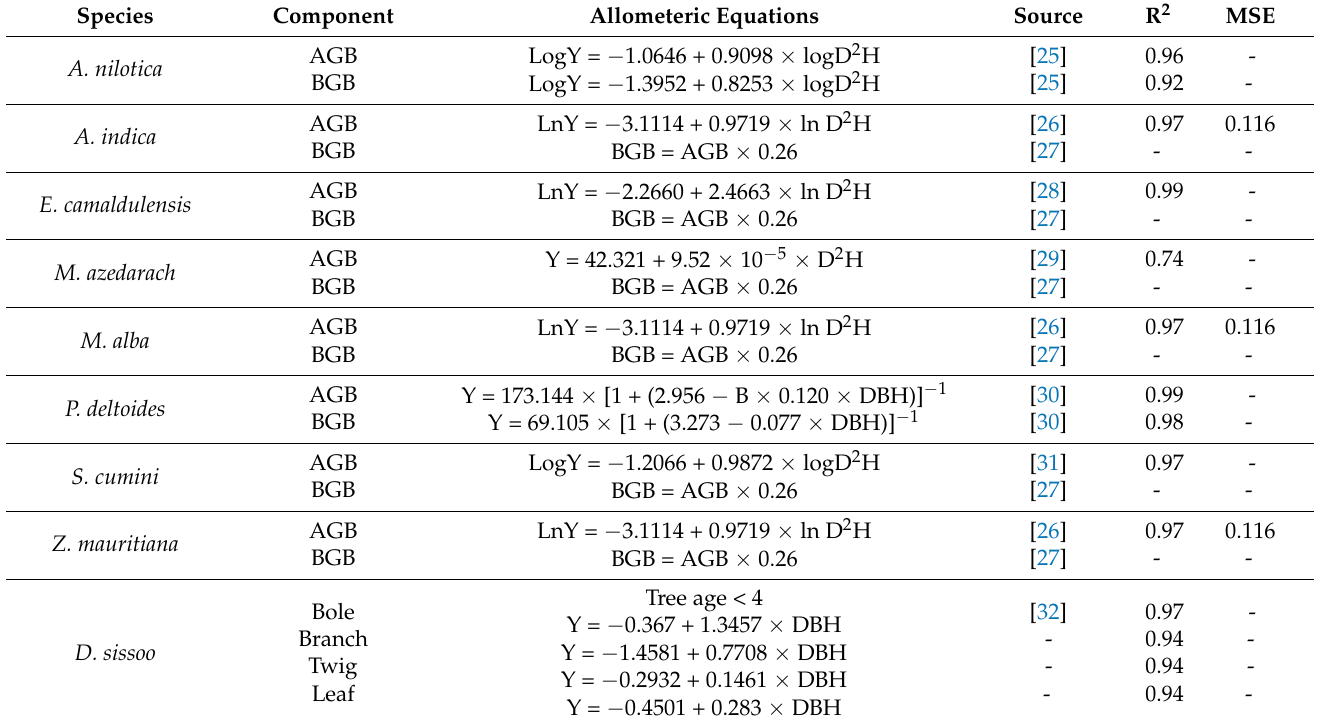
Table 3. Allometric equations for the calculation of above and below ground